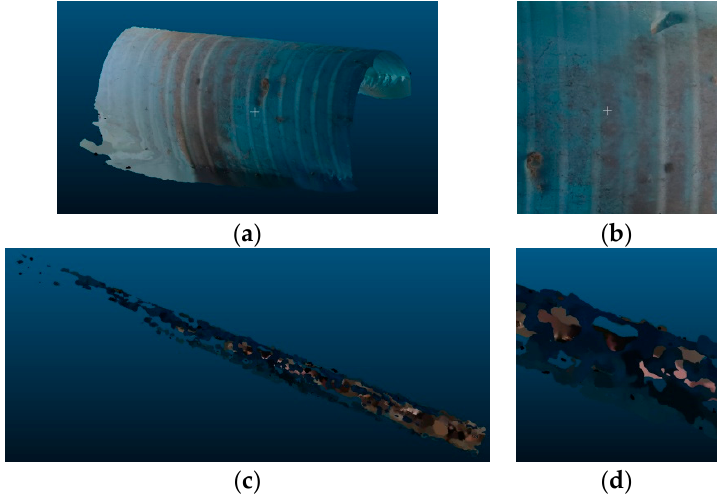
Figure 11. Reconstruction results based on side-view images ( a , b ), and reconstruction results based on front-view images ( c , d ).